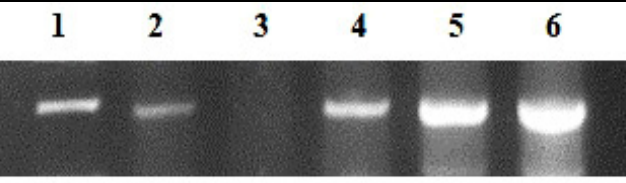
Figure 4. DNA damage protection by endophytic fungal EtOAc extract of P. neglecta. Lane 1: native λ DNA, Lane 2: λ DNA + Fenton’s reagent + quercetin; positive control, Lane 3: λ DNA + Fenton’s reagent, Lane 4: λ DNA + EF2 (200 µg) Fenton’s reagent + Extract (0.1 µg mL − 1 ), Lane 5: λ DNA + Fenton’s reagent + Extract (1.0 µg mL − 1 ), Lane 6: λ DNA + Fenton’s reagent + Extract (10 µg mL − 1 ).